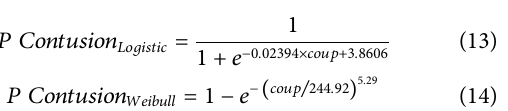
Frontiers in Bioengineering and Biotechnology |